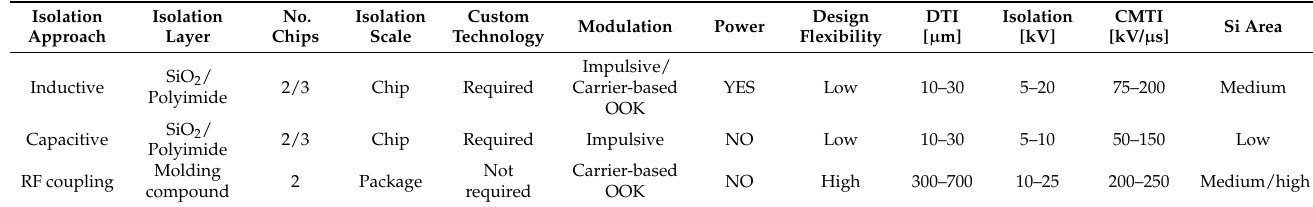
Table 1. State-of-the-art galvanic isolation approach comparison.